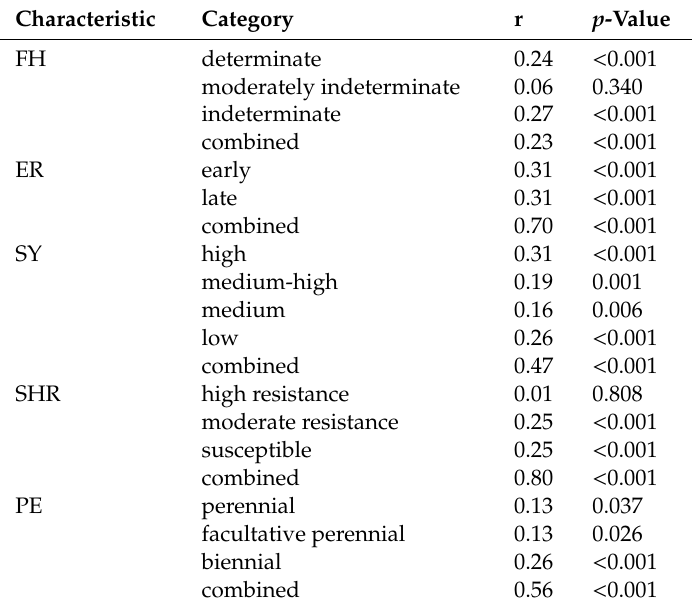
Table 2. Pearson correlation coe ffi cients between site-1 and site-2 for the five characteristics ( flowering habit (FH), earliness (ER), seed yield per plant (SY), pod shattering resistance (SHR), and perenniality (PE)) recorded in the F 3 population, based on frequencies of each category and each characteristic as a whole (combined).